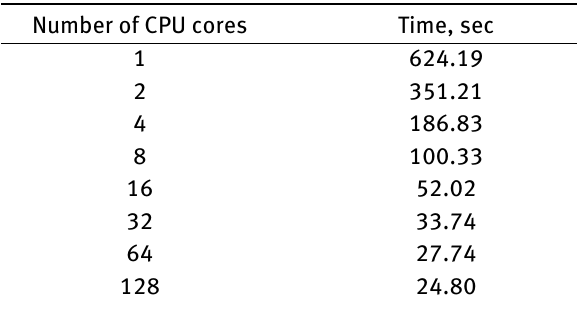
Figure 10: Performance of the molecular dynamic simulations of 125 million Lennard-Jones spheres using Gromacs 2018.3 as a function of nodes number. Note, that there are only 26 GPU nodes in the